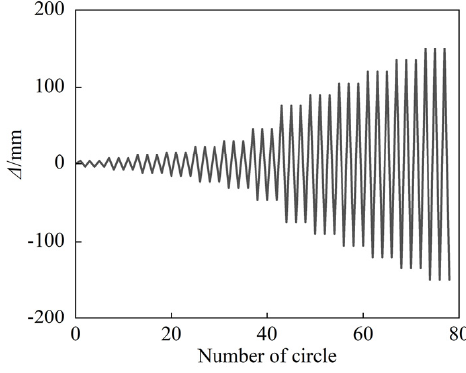
Figure 3. Cyclic loading protocol.